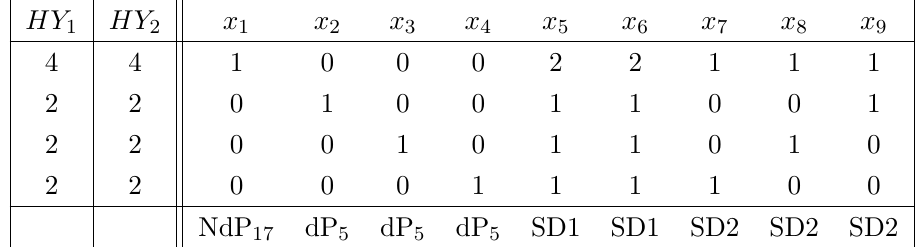
Table 3 . Toric data of X